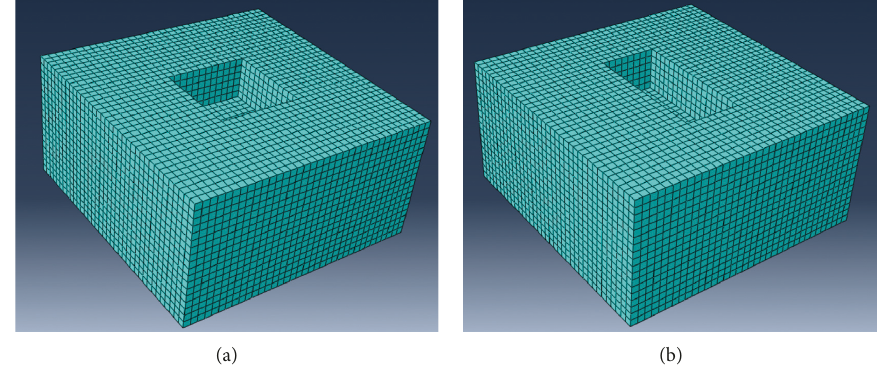
Figure 1: Soil models. (a) Configuration-1. (b) Configuration-2.